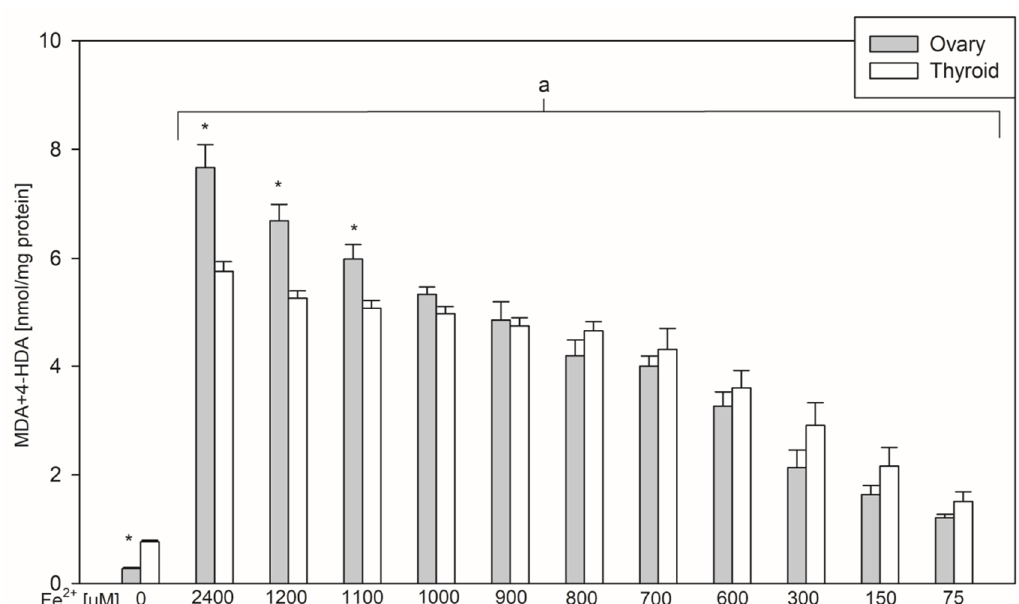
Figure 3. The concentrations of malondialdehyde + 4-hydroxyalkenals (MDA + 4-HDA) in porcine ovary and thyroid homogenates. Homogenates were incubated in the presence of FeSO 4 (2400, 1200, 1100, 1000, 900, 800, 700, 600, 300, 150, and 75 µ M) plus H 2 O 2 (5 mM) used to induce lipid peroxidation. Data are expressed as the amount of MDA + 4-HDA (nmol) per mg of protein. Bars represent the mean ± SE of five independent experiments run in duplicates. a p < 0.05 vs. control ‘0’ in the same tissue; * p < 0.05 vs. the same concentration in the other tissue.